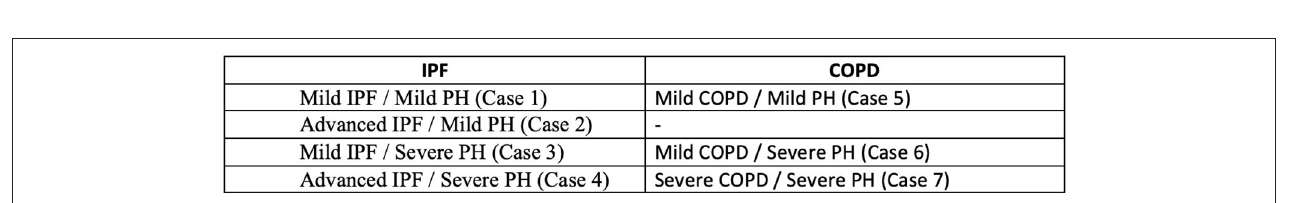
with PVR > 3 WU, or mPAP 25–34, (3) CLD with severe PH